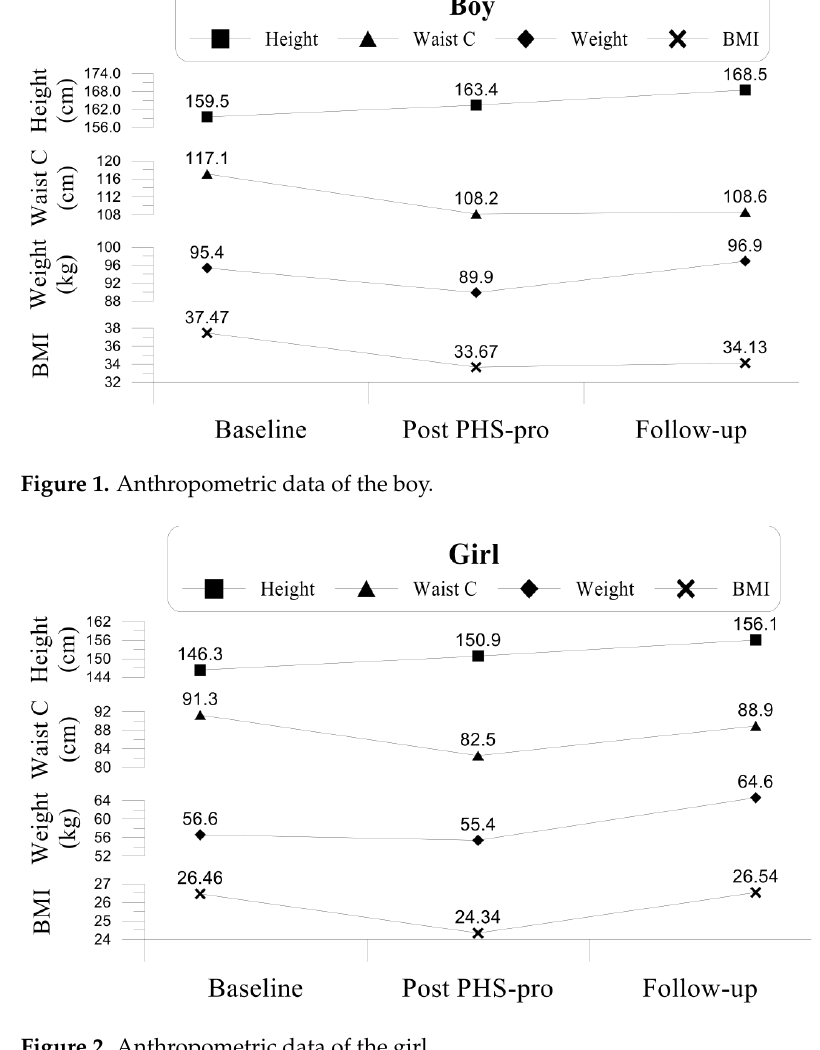
Figure 2. Anthropometric data of the girl